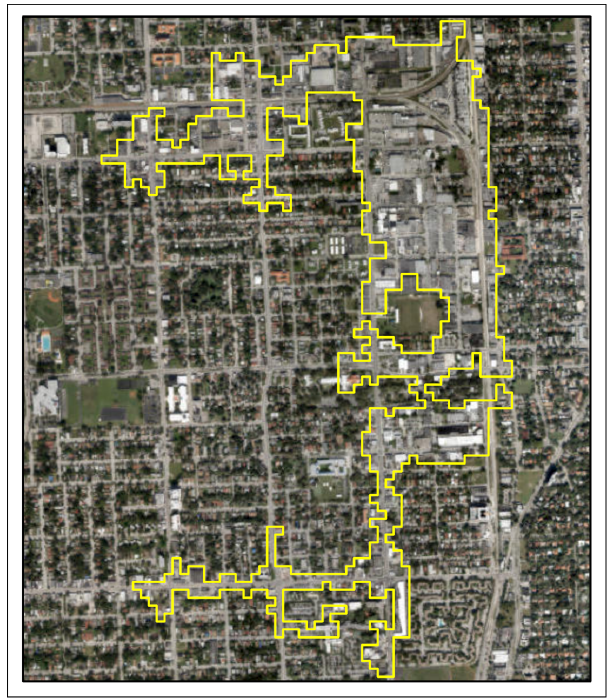
Figure 6. NBI-derived object of industrialized land in Little Haiti. Table 5. Area statistics of NBI-derived object, referencing FGDL data.